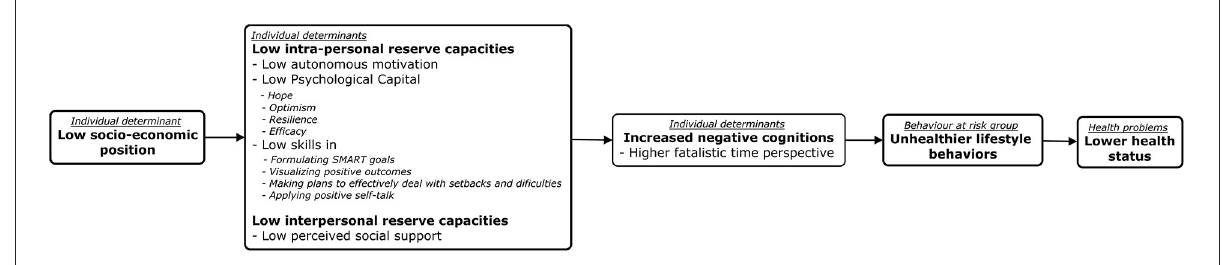
FIGURE2 Logic model of the problem. Based on the Reserve Capacity Model [e.g.,